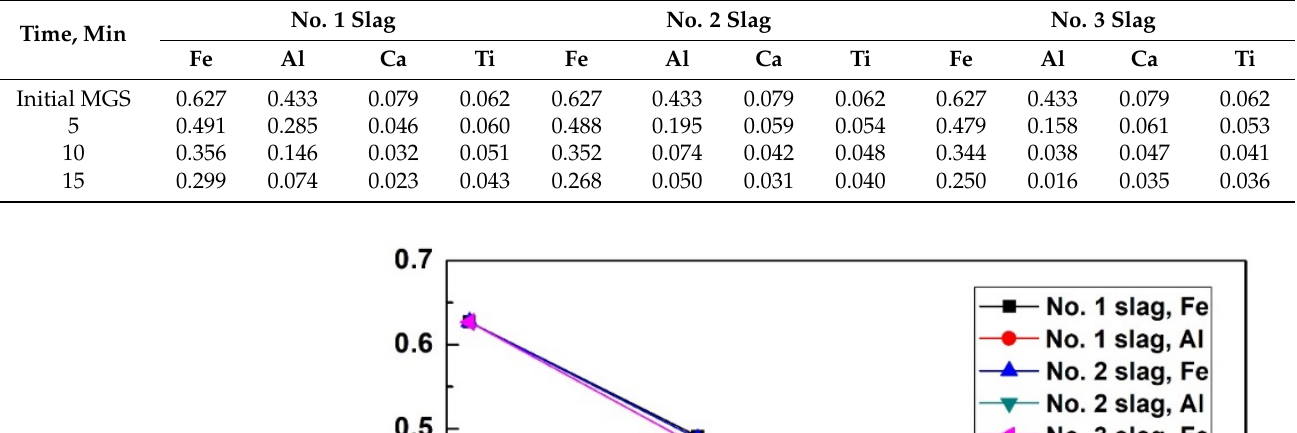
Table 3. Content of typical impurity elements of silicon samples obtained during refinement, wt%.